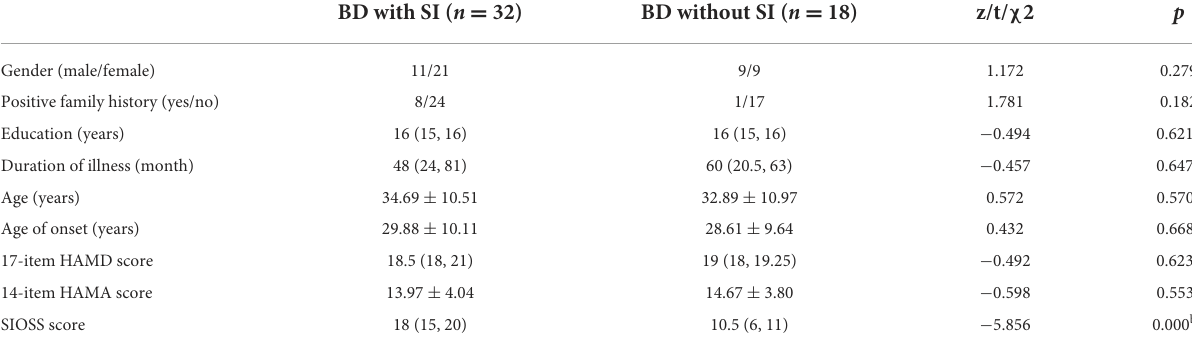
TABLE 1 Demographic and clinical data of BD patients with and without SI. BD with SI ( n = 32) BD without SI ( n = 18)